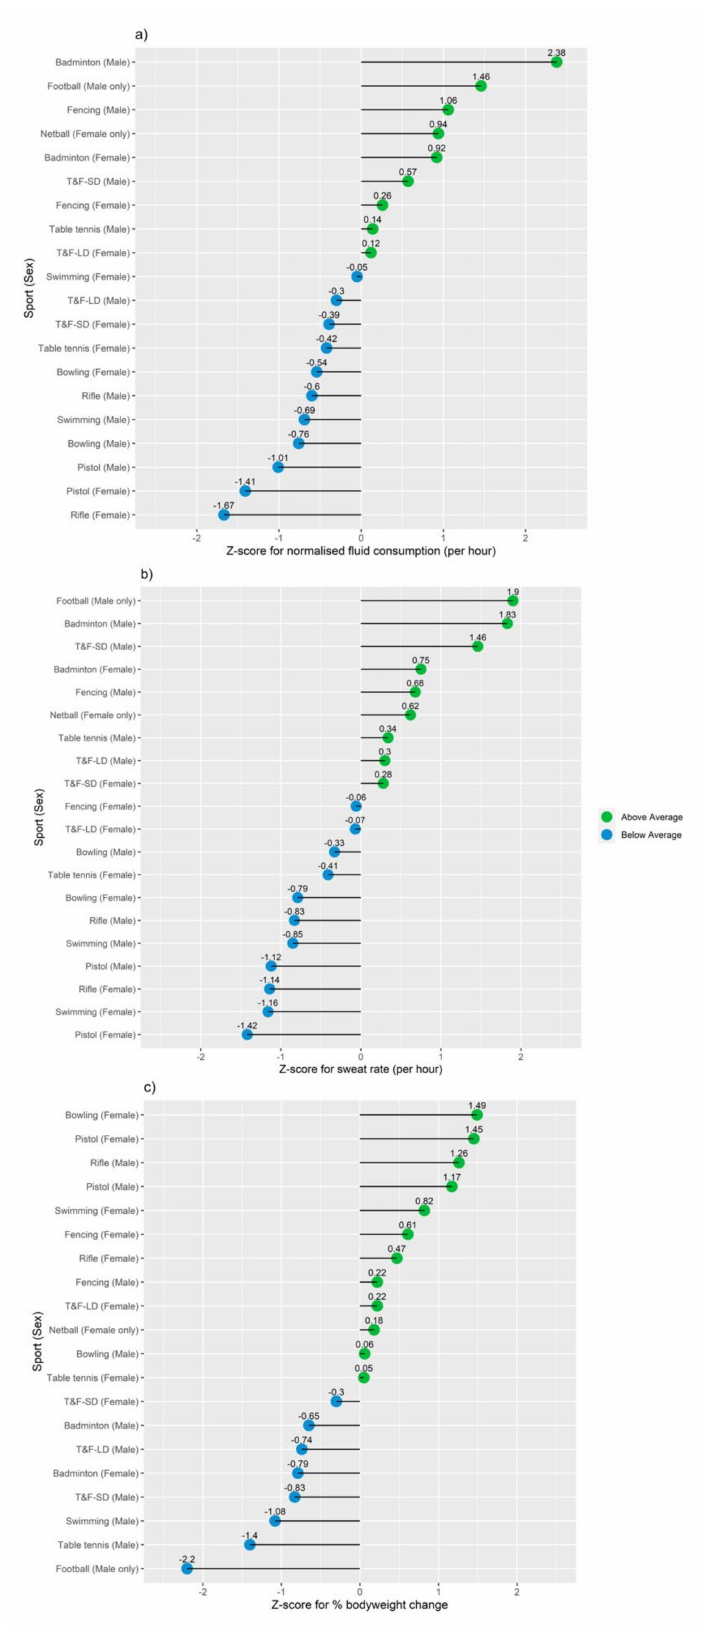
Figure 1. Effects of training on fluid balance and hydration status by sport and sex. ( a ) Z-score plot of fluid consumption (per hour). ( b ) Z-score plot of sweat loss (per hour). ( c ) Z-score plot of percentage body mass